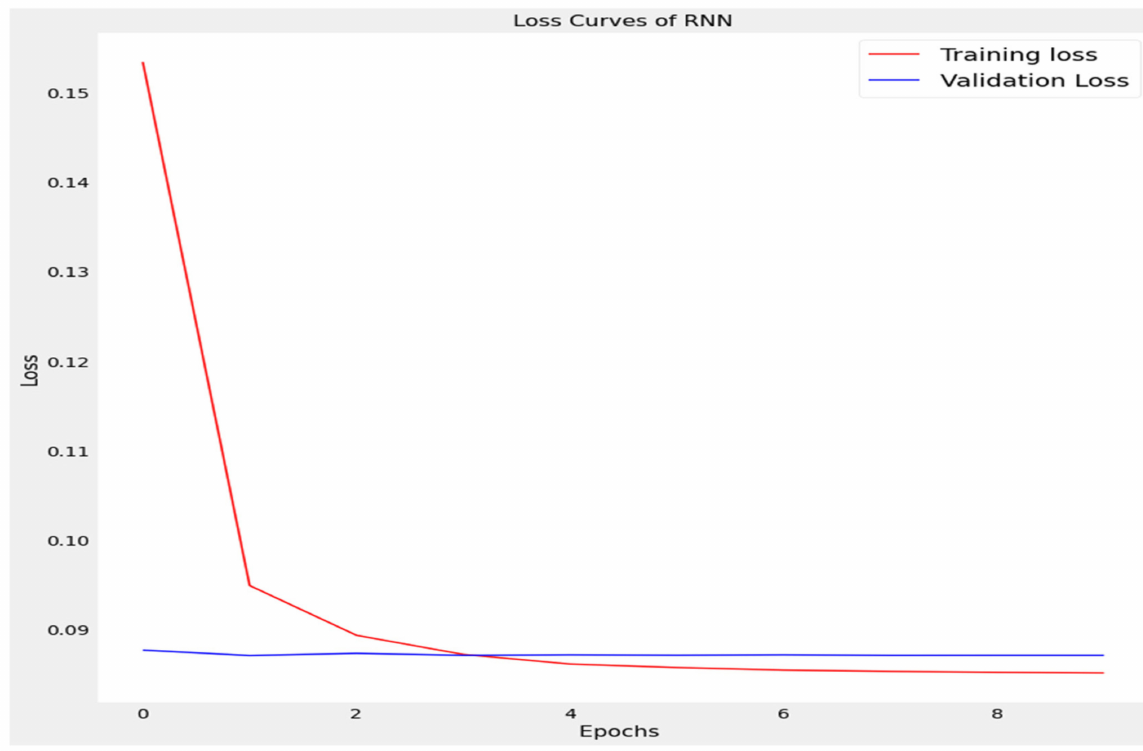
Figure 7. Loss curve of recurrent neural network